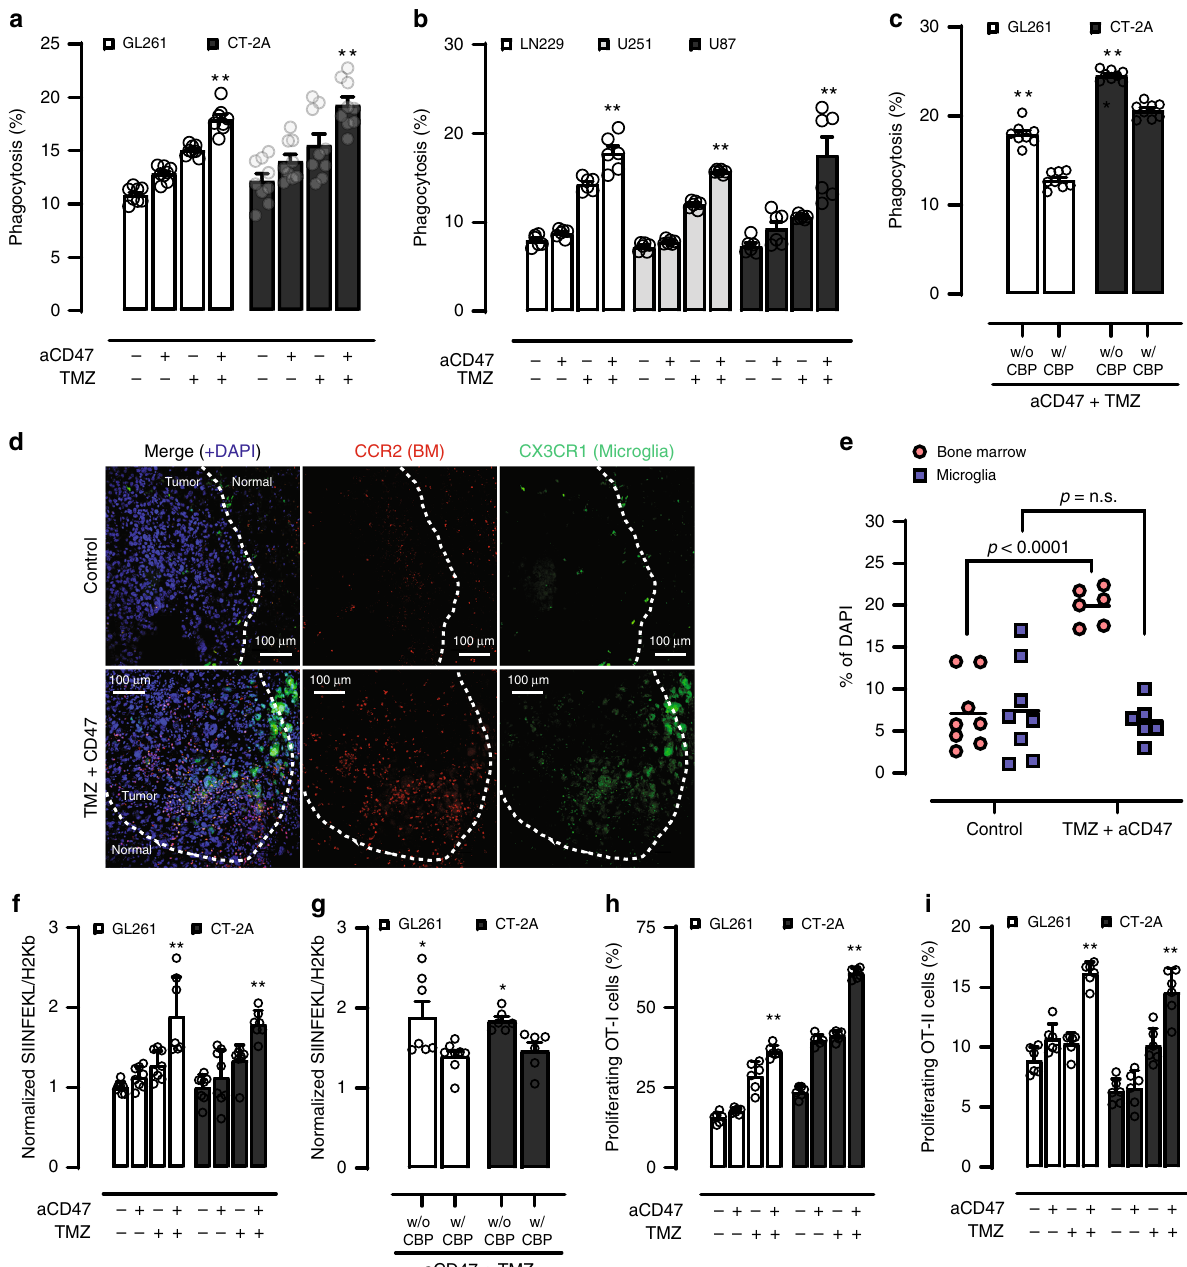
Fig. 3 Combined TMZ and CD47 blockade enhances GBM cell phagocytosis and cross-priming of antigen-speci fi c T cells by BM antigen presenting cells (APCs). Combined TMZ and anti-CD47 antibody (aCD47) treatment enhances murine ( a ) and human ( b ) GBM cell phagocytosis by BM APCs. GL261, n = 8; CT-2A, n = 9; LN229, U251, U87, n = 6. ** p < 0.05, one-side ANOVA with Bonferroni post hoc correction. c Blocking of calreticulin negated the enhanced phagocytosis effect of combined TMZ and anti-CD47 antibody treatment. n = 8, ** p < 0.01, unpaired Student ’ s t test. d Immuno fl uorescence images of tumor in fi ltrating BM cells (red) and microglia (green). e Quanti fi cation of tumor-in fi ltrating BM cells and microglia. Control, n = 8; combo, n = 6. Unpaired Student ’ s t test. f Combined TMZ and anti-CD47 antibody treatment enhanced the cross-presentation of MHC-bound cOVA-derived SIINFEKL peptide on APCs. n = 8, ** p < 0.01, one-side ANOVA with Bonferroni post hoc correction. g The enhanced antigen cross-presentation effect mediated by combined TMZ and anti-CD47 antibody was reduced with the addition of a calreticulin blocking peptide. GL261, n = 8, CT2A, n = 5. ** p < 0.01, unpaired Student ’ s t test. h , i Combination TMZ and anti-CD47 antibody treatment enhanced cross-priming of cOVA antigen speci fi c T cells. n = 6, ** p < 0.01, one- side ANOVA with Bonferroni post hoc correction. Error bar = mean ± standard